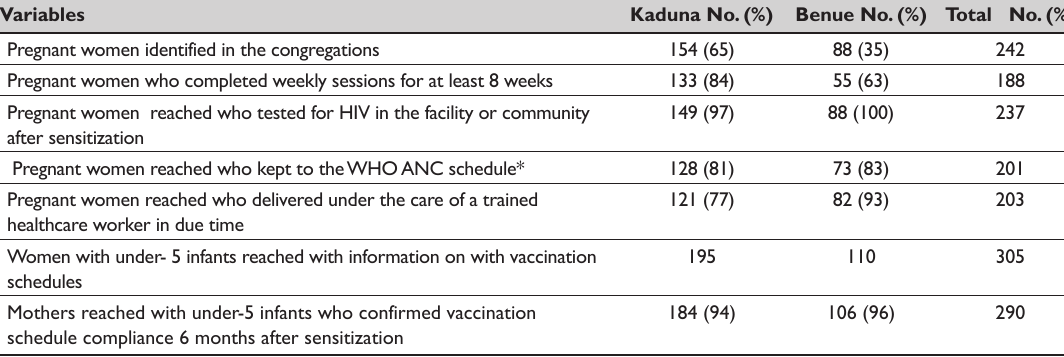
Table 2: Uptake of MCH related services by pregnant women in project congregations Variables